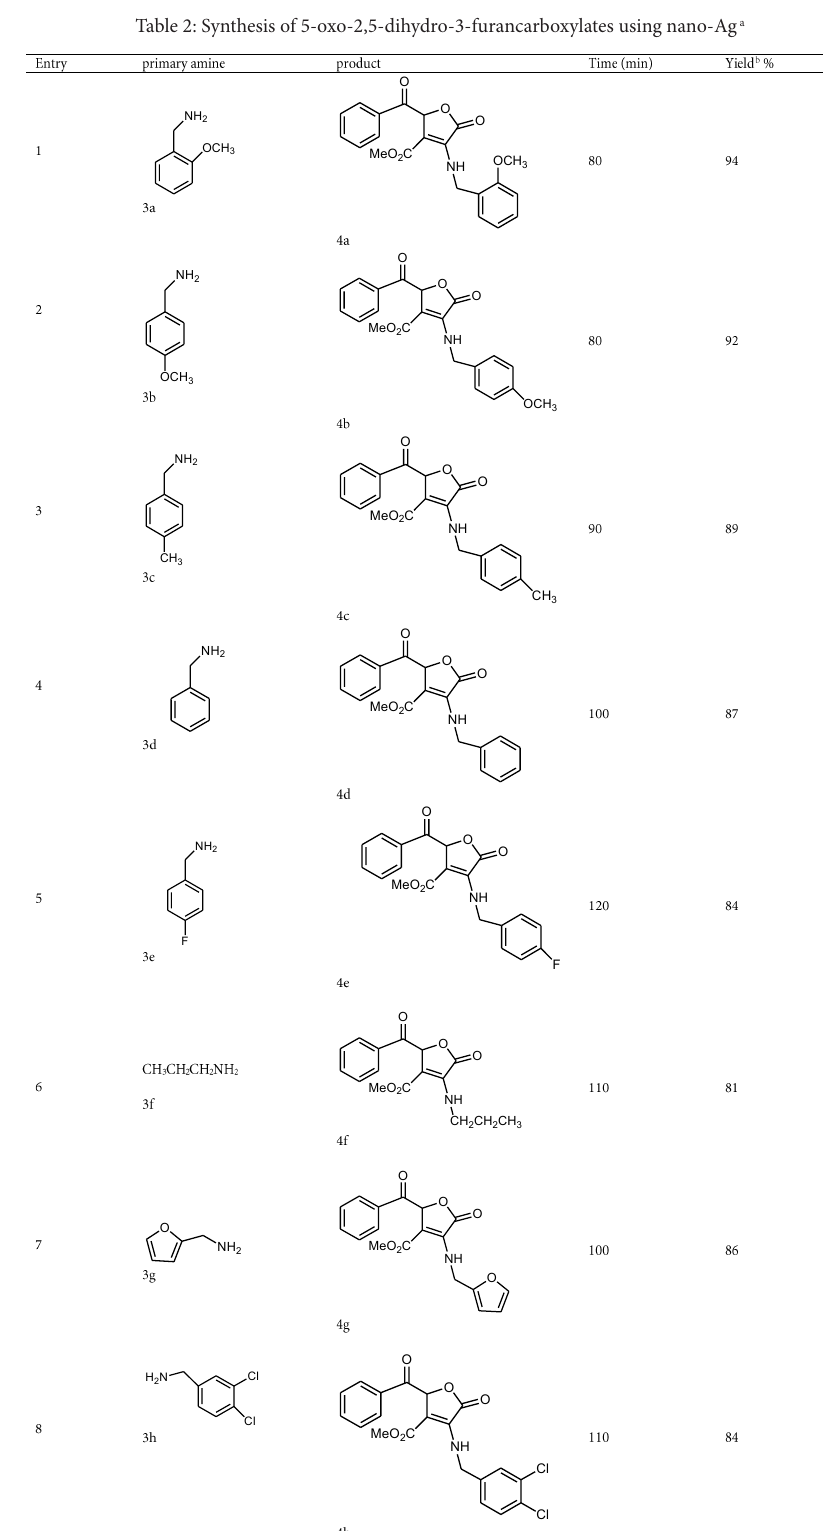
Table 2: Synthesis of 5-oxo-2,5-dihydro-3-furancarboxylates using nano-Ag